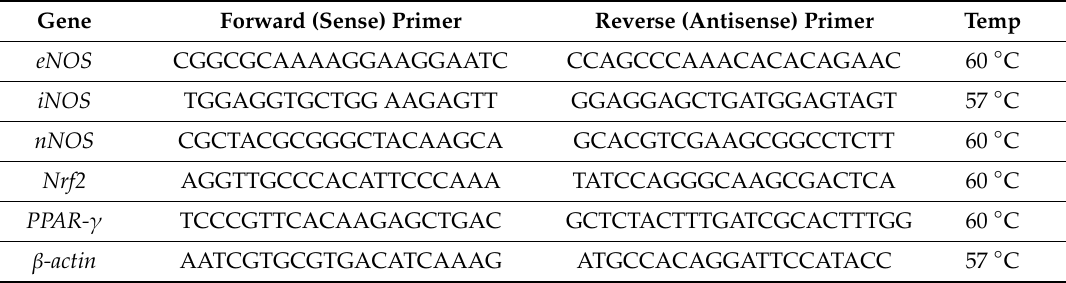
Table 1. Primer pairs used to amplify selected